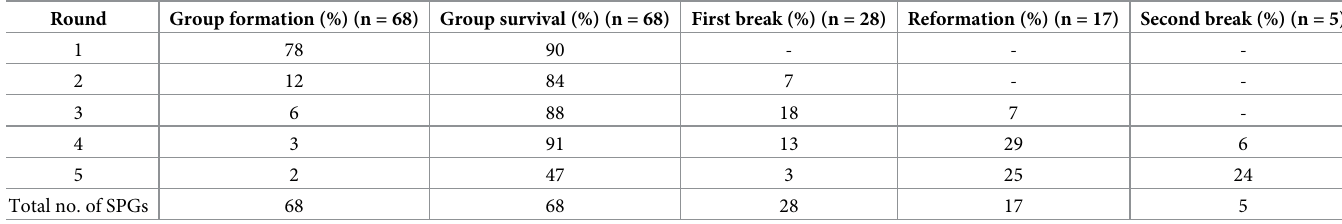
Table 5. Group dynamics and